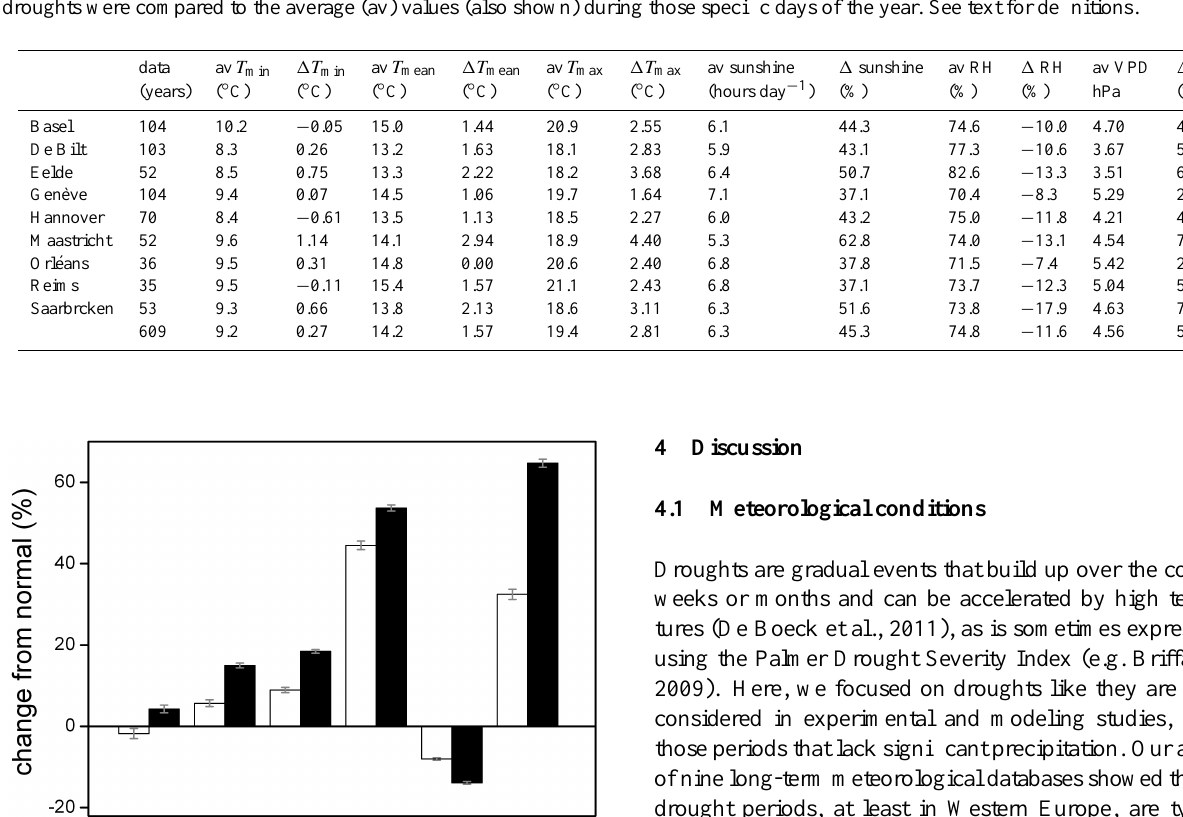
Table 2. Overview of meteorological conditions for all nine weather stations used in our analyses, from 15 March until 15 October. Anoma- lies ( 1) during droughts were calculated for each day and then averaged: i.e. daily values (temperatures, sunshine hours, etc.) during droughts were compared to the average (av) values (also shown) during those specific days of the year. See text for definitions.